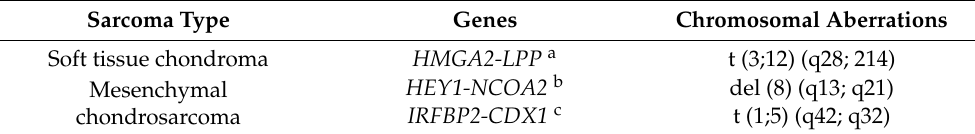
Table 1. Genetic fusions and chromosomal aberrations in chondrosarcoma. Modified and based on [66]. Sarcoma Type Genes Chromosomal Aberrations Soft tissue chondroma HMGA2-LPP a